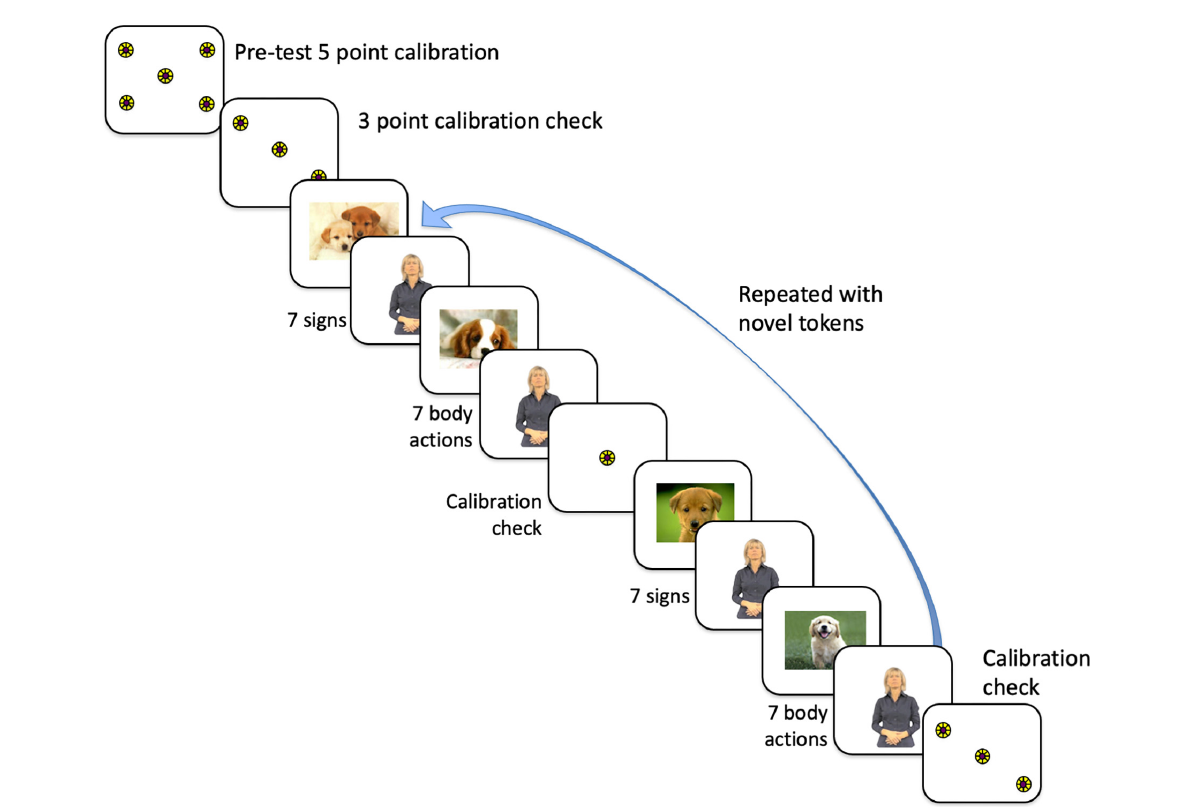
FIGURE1 Order of presentation of stimuli to participants, which first commenced with a 5-point calibration routine, then a 3-point calibration check. We proceeded with the experiment only if that calibration was within the tolerance limits (with gaze falling on each circle). The experimental conditions consisted of alternating trials of 7 signs and trials of 7 body actions, either grooming or pantomimes, with each trial presented twice. Participants never saw the same token twice. For the data analysis, the trials were collapsed to eliminate order effects.